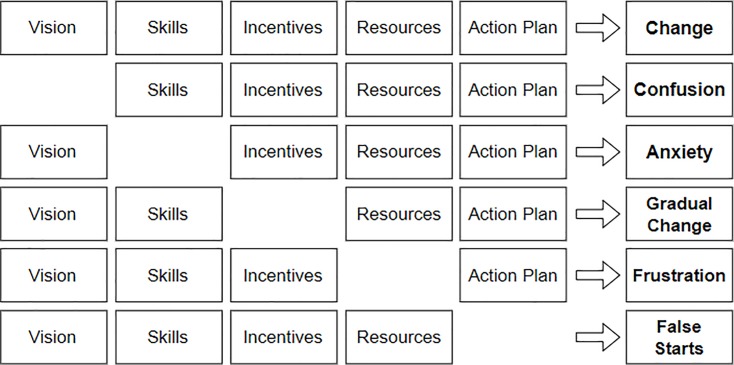
Effects of missing elements [38].